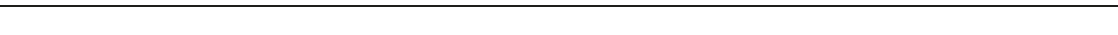
Fig. 1 Zone-speci fi c polyploidization in Per -null mouse liver. a – c A representative HE-stained image of liver in WT and Per- null mice (male, 12 weeks old; n = 6 mice for each group). High magni fi cation photos of indicated areas of a are shown in b . Wide view of HE-stained Per -null mouse liver ( c ) shows clear zone-speci fi c difference of hepatocytes. Hepatocytes encircling the central vein (CV) have larger nuclei than those encircling the portal vessels (PV). Dotted line borders between the two groups. d Zone-speci fi c nuclear sizes stained with Hoechst-33342 of WT and Per -null mice. The bar graph shows the distribution of variant hepatic nuclear size (nuclear square: μ m 2 ) along with the CV-PV axis. The CV-PV axis was subdivided into 15 parts (left schema), and the less number indicates the region closed to central vein region. The traditional 3-zone classi fi cation of hepatic lobule divides CV-PV axis into three equal parts: namely, centrilobular zone corresponds to 1 – 5, midlobular zone to 6 – 10, and periportal zone to 11 – 15. Note signi fi cant increase of nuclear diameter in Per -null hepatocytes than those of WT was observed from part 3 to 9, which distributes both centrilobular and midlobular zones, and thus, we describe these cells to centro-midlobular hepatocytes (CMH) separating from periportal hepatocytes (PH). The results were generated from fi ve mouse livers for each group, and three different lobules were analyzed in each liver. e Frequency distributions of nuclear sizes of WT and Per -null CMH ( e ) and PH f ( n > 2500 cells from 5 mice for each group). g Developmental changes of nuclear sizes of CMH in WT and Per -null liver. The size of Hoechst-33342 stained nuclei was plotted against frequency distributions ( n > 2000 cells from 3 mice for each group). Flow sorting of single hepatocytes on the basis of DNA content against cellular area shows dot plot graphs h for gating criteria and histograms i of Hoechst-33342 stained nuclei, showing the DNA content of WT and Per -null hepatocytes at 3 weeks ( n = 3) and 12 weeks ( n = 4) of age. Data are representative of at least three independent experiments. Two- tailed unpaired Student ’ s t -test with Welch correction was applied to d ; Two-way ANOVA with Bonferroni ’ s post-test was used to ( i ). Values represent the mean ± SEM, * P < 0.05, ** P < 0.01, *** P < 0.001. Scale bars, 100 μ m in a , c , g , 20 μ m in